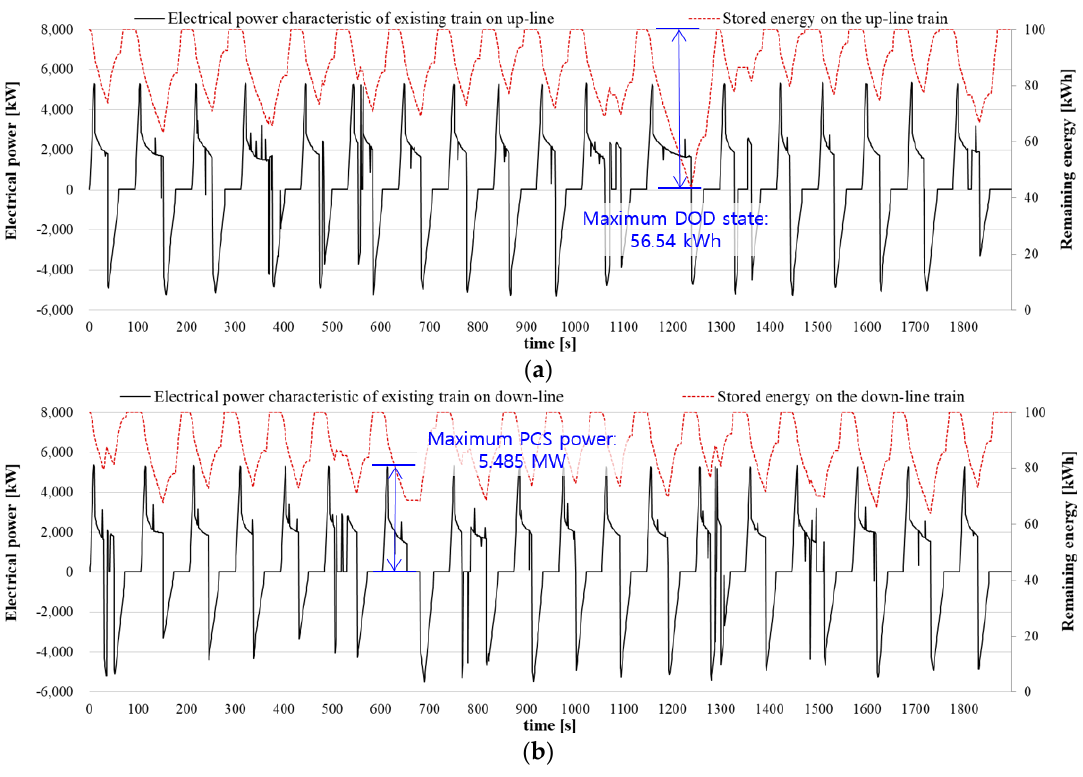
Figure 6. Electrical power characteristics and stored energy variation for the up- and down-line train at iteration step 0. ( a ) up-line train; ( b ) down-line train.